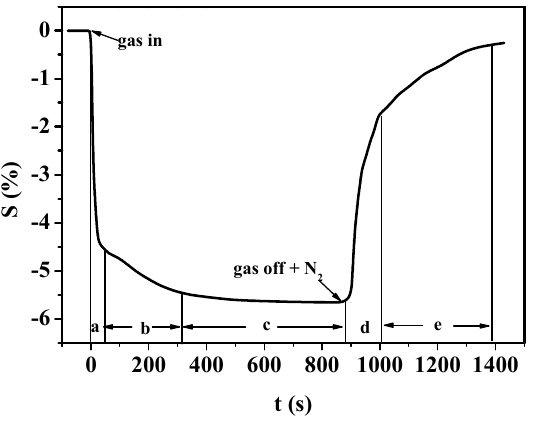
Figure 16. Response and recovery curve of PANI-SSA sensor to H 2 S.